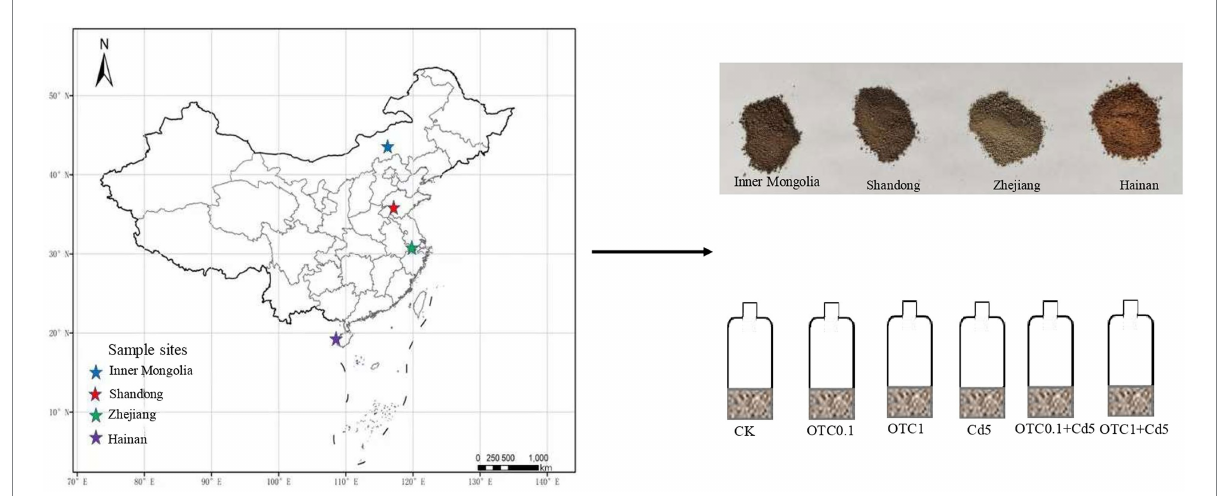
FIGURE 1 Sampling sites and soils in Inner Mongolia, Shandong, Zhejiang, and Hainan provinces from north to south of China. CK, control treatment without contamination; OTC0.1, OTC addition at 0.1 mg·kg − 1 ; OTC1, OTC addition at 1 mg·kg − 1 ; Cd5, Cd addition at 5 mg·kg − 1 ; OTC0.1 + Cd5, OTC addition at 0.1 mg·kg − 1 and Cd addition at 5 mg·kg − 1 ; OTC1 + Cd5, OTC addition at 1 mg·kg − 1 , and Cd addition at 5 mg·kg − 1